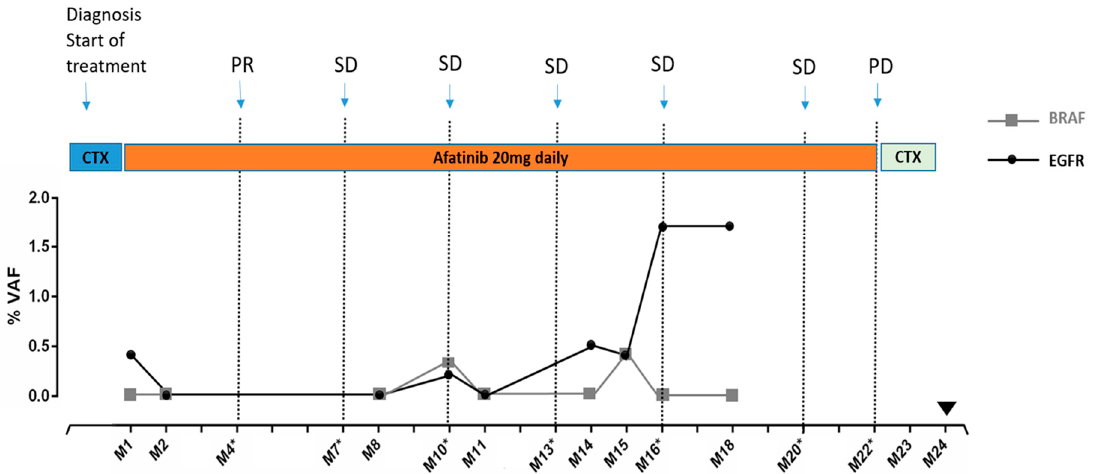
Figure 3. EGFR and BRAF mutations detection in ctDNA from one patient with known EGFR